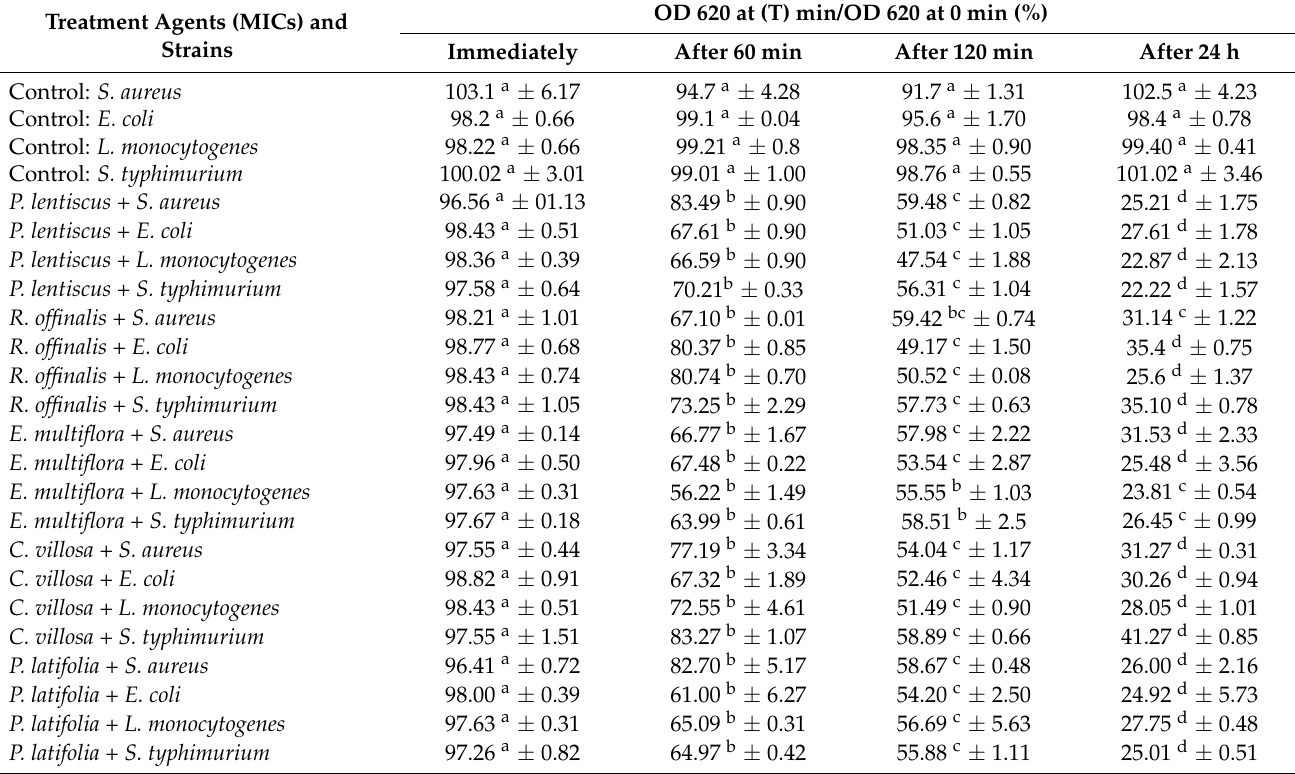
Table 3. The proportion of initial OD620 of suspensions of Escherichia coli , Salmonella typhimurium , Listeria monocytogenes , and Staphylococcus aureus remaining after treatment with MICs of Pistacia lentiscus , Rosmarinus officinalis , Erica multiflora , Calicotome villosa , and Phillyrea latifolia ethanolic extracts for 60 min, 120 min, and 24 h.